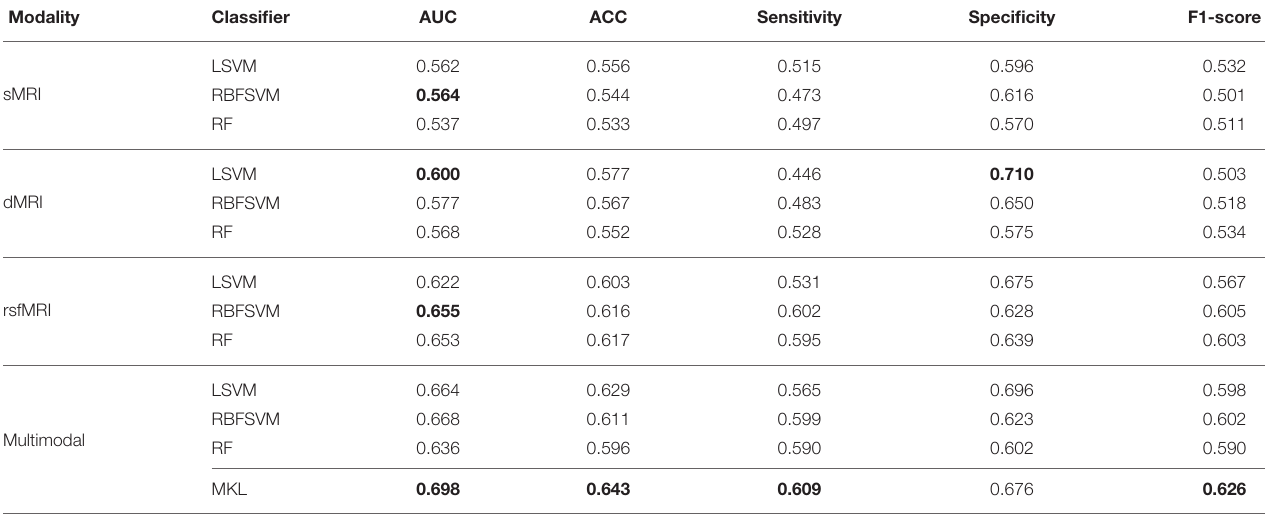
TABLE 3 | Performances of unimodal and multimodal